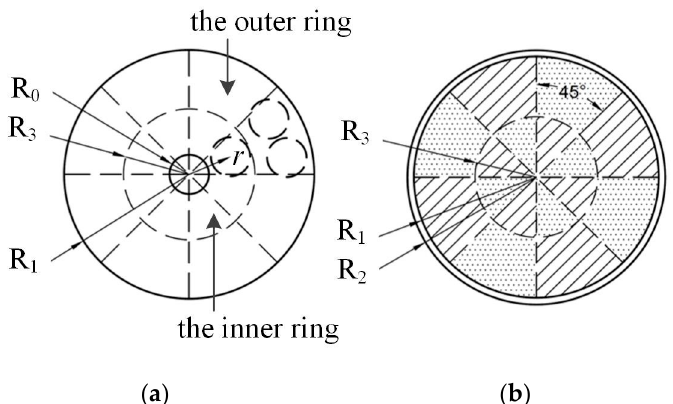
Figure 6. Cross-sectional area division of the duct model. ( a ) Placement of the steel bar in the duct; ( b ) the 16 segments.